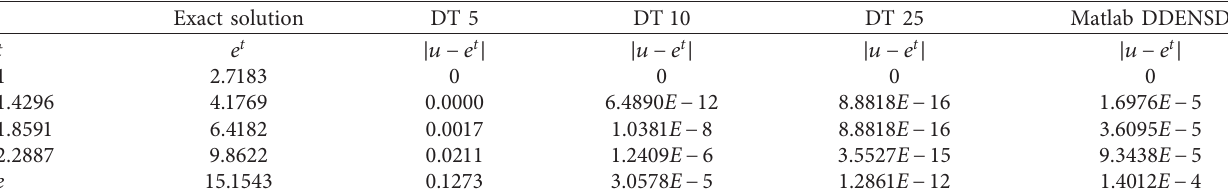
Table 1: Example 1, error analysis of u in [ 1 ,e ] .